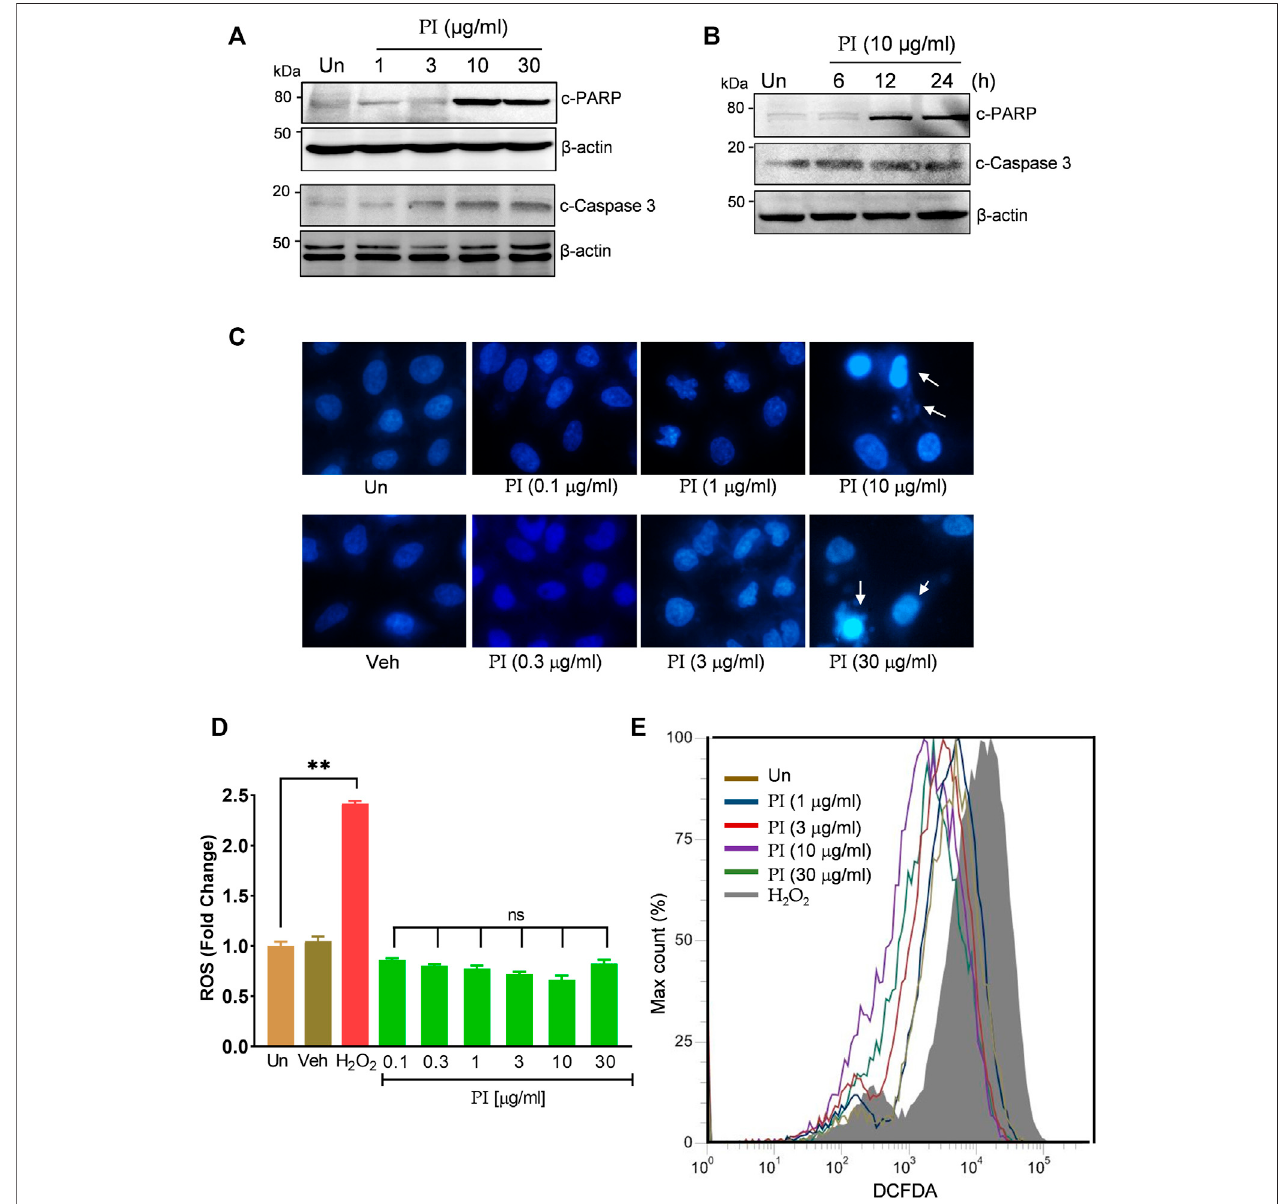
FIGURE 3 | Pistacia integerrima potentiates ROS-independent apoptosis in lung cancer cells. (A) Whole cell lysates of A549 cells post 24 h of treatment at indicated doses were subjected to Western blotting using antibodies against cleaved PARP1 and cleaved caspase 3. β -Actin served as the loading control. (B)